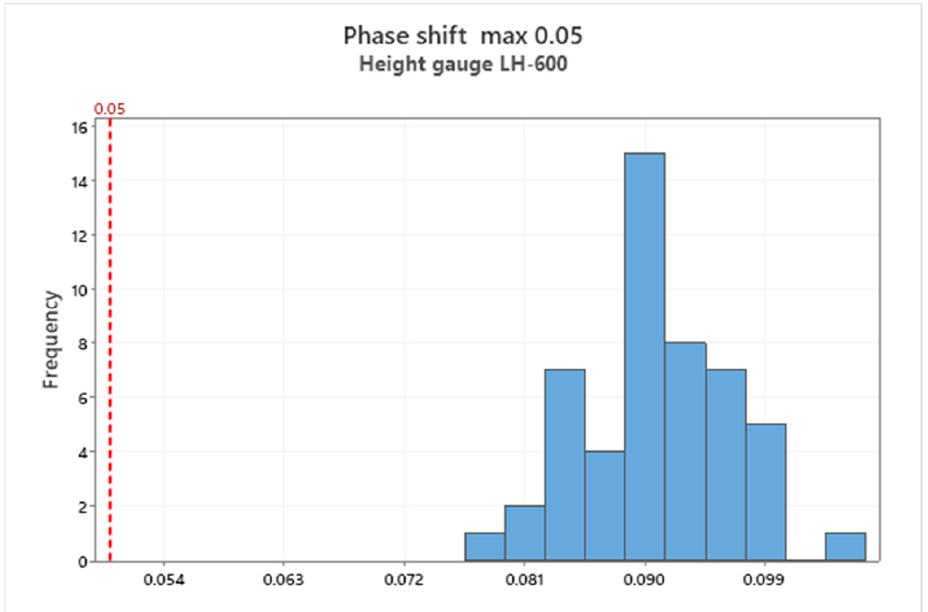
Figure 13. Tooth height 5 ± 0.08 mm—histogram from measurements obtained with the Multisensory Measuring Machine Werth Scope Check, values on x axis given in mm (own study).